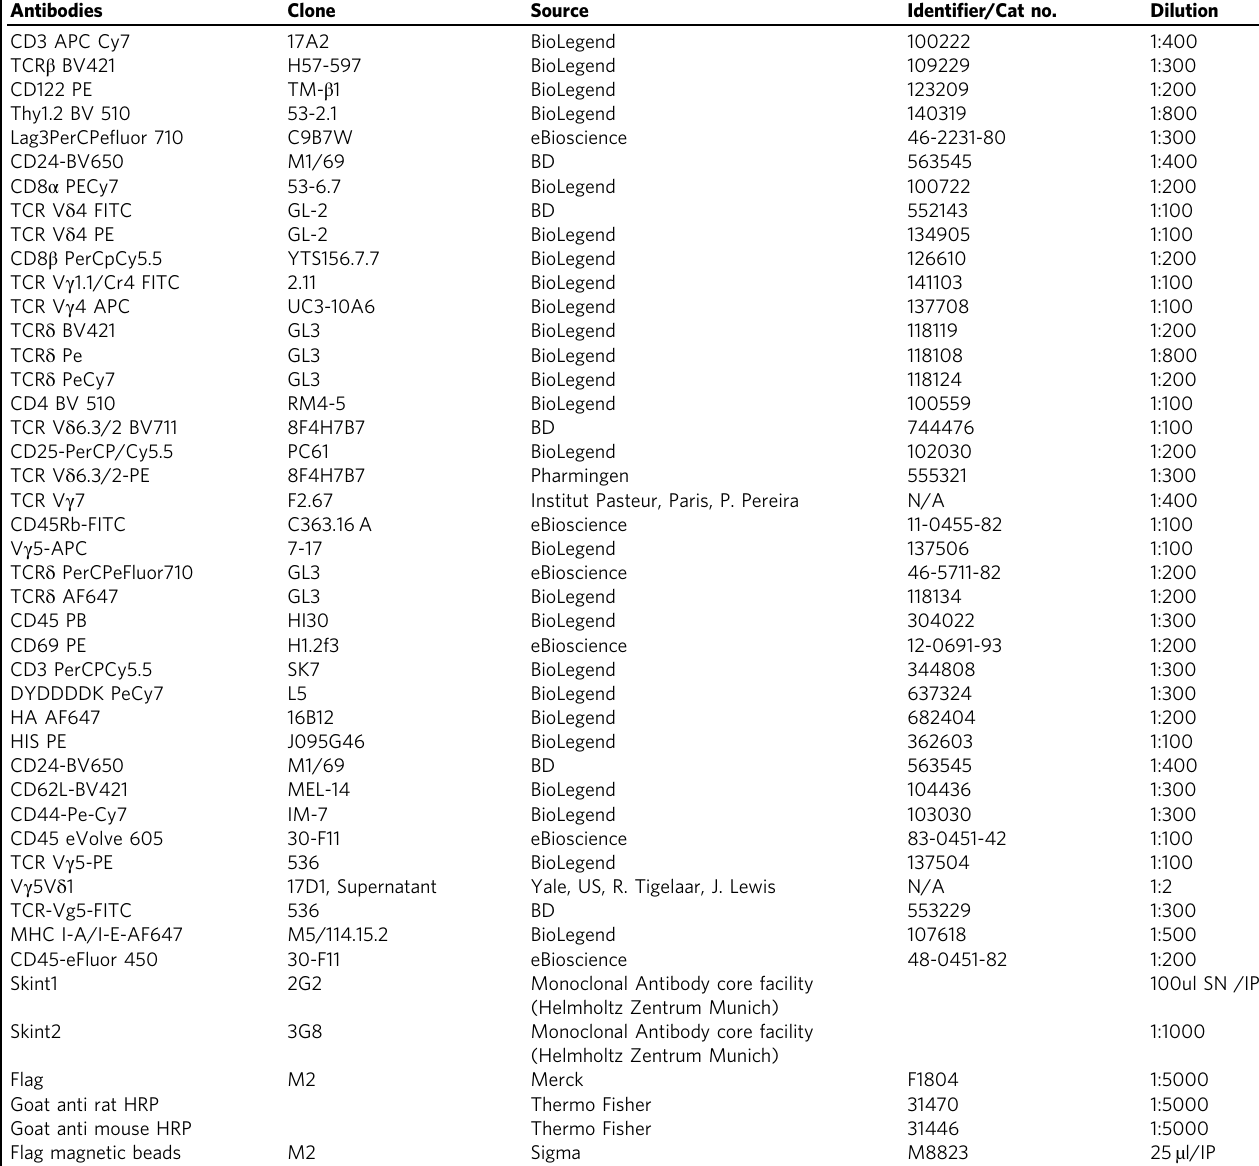
Table 3 Antibodies used for fl ow cytometry, western blotting and microscopy.